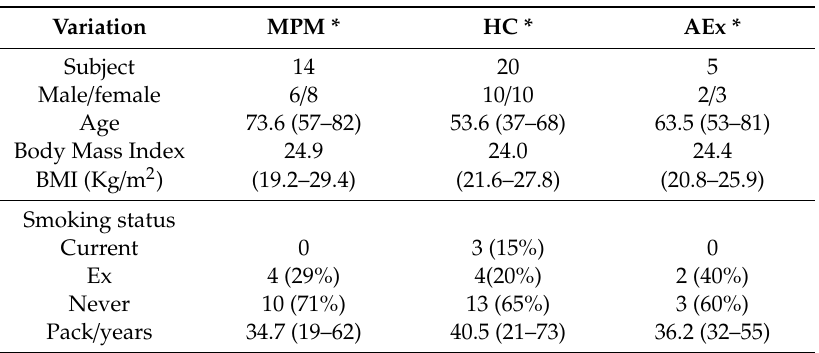
Table 1. Patient